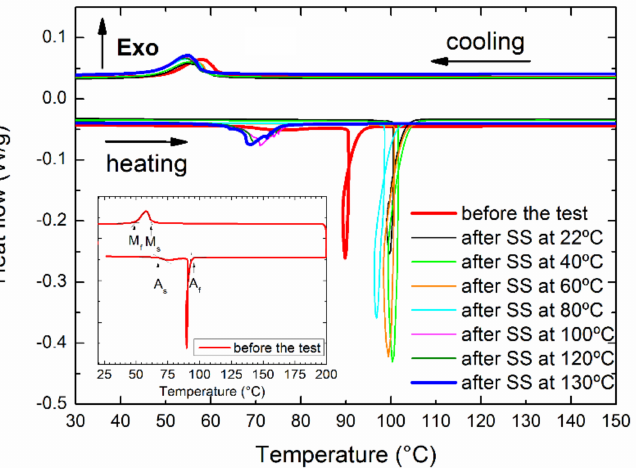
Figure 3. DSC heating and cooling runs measured before the first stress–strain (SS) test and after each compression SS cycle at the constant temperature indicated in the graphs. The inset illustrates the determination of the MT characteristic temperatures in the as-received sample before testing for which the two-step reverse MT is observed on the heating curve (see experimental